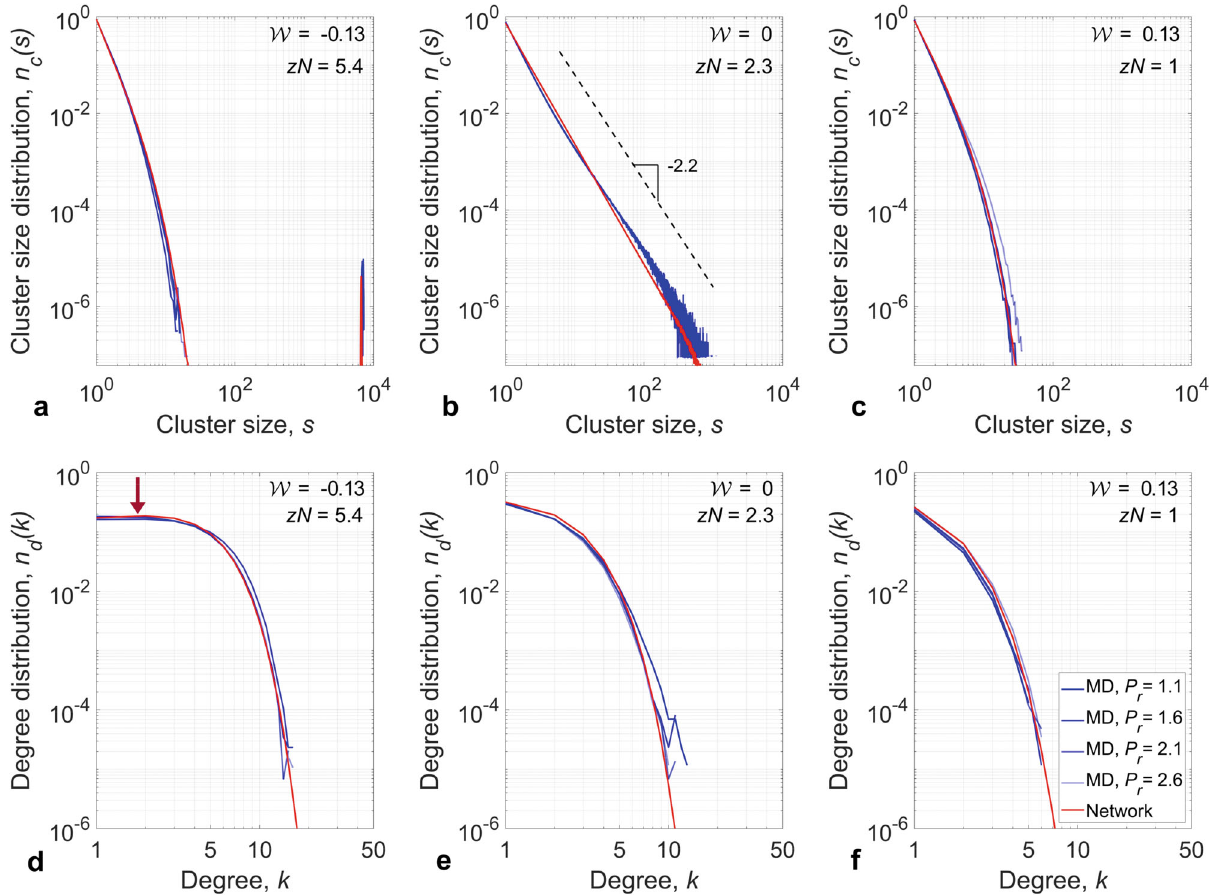
Fig. 4 | Topology of supercritical fl uids. (top row) Cluster size distributions and (bottomrow) degreedistributionforsupercriticalwaterandthecomplexnetwork model. Different shadesofblue represent isobars, (dark to light) P r : 1.1,1.6, 2.1, 2.6, respectively. Both quantities exhibit three distinct regimes: ( a , d ) liquid-like state